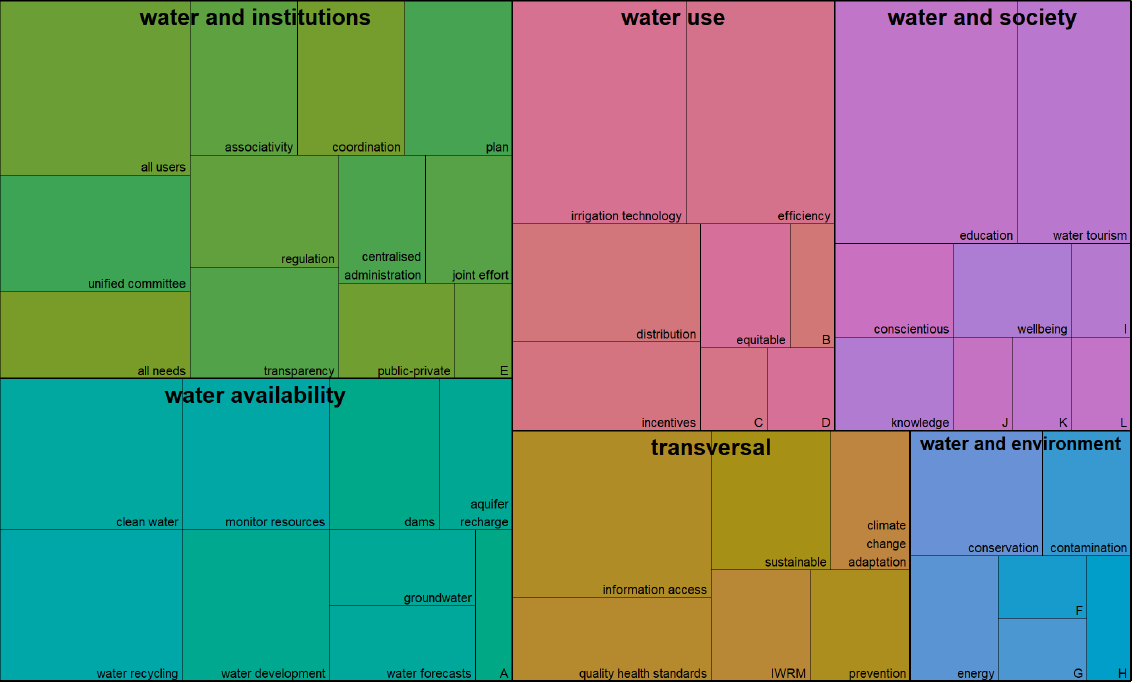
Figure 5. Treemap identifying most recurrent topics raised by stakeholders of circle C at initial extended participatory workshops. Size reflects the proportion of mentions by stakeholders. Note, A, meteorological stations; B, guaranteed use; C, reduce losses; D, accumulation; E, support; F, reforestation; G, solid waste management; H, environmental services; I, professionalism; J, solidarity; K, training; L,